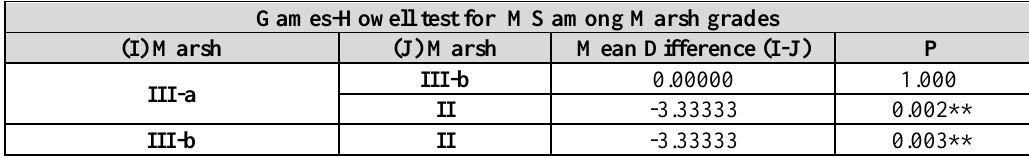
Table 4: Multiple comparisons of missing component (MS)of DMFS among the three available Marsh grades. Games-Howell test for MS among Marsh grades